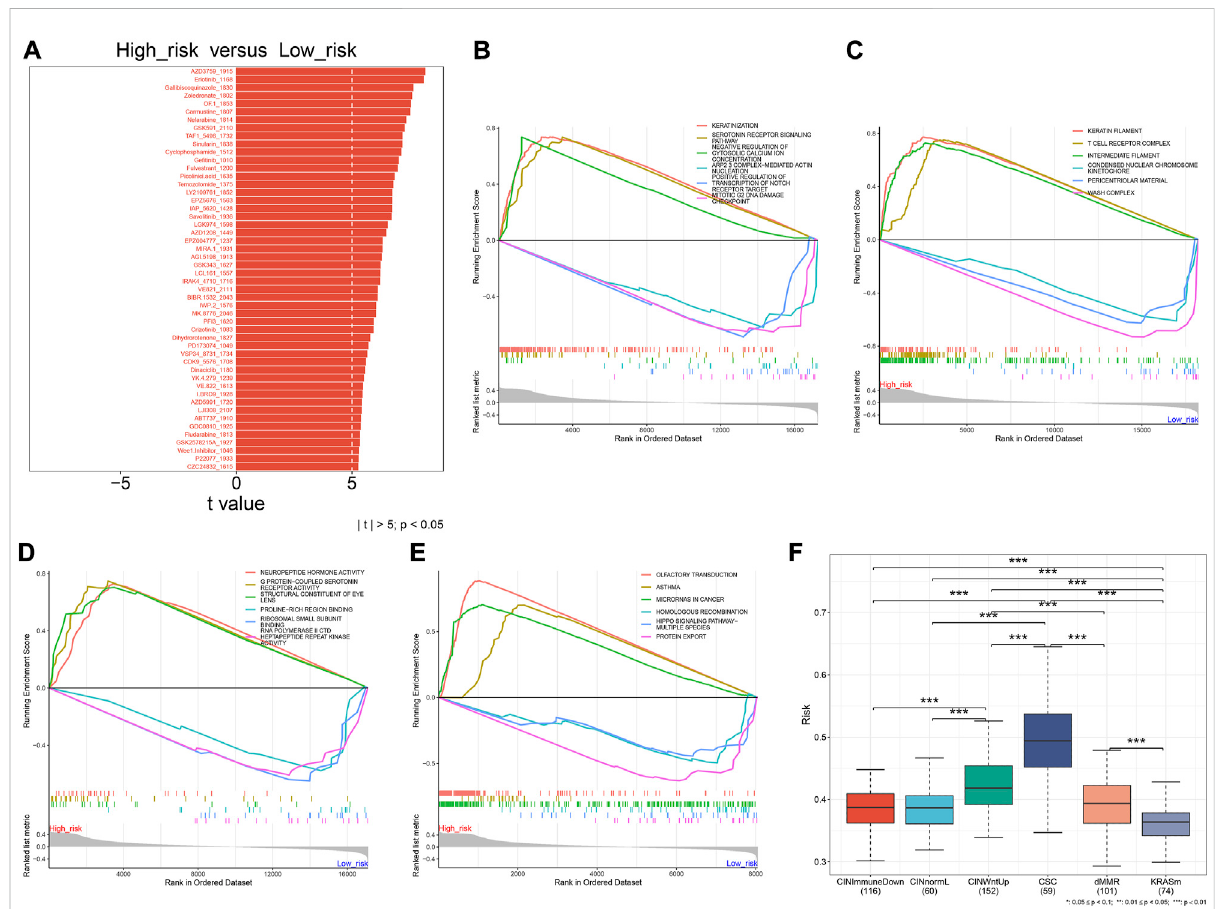
FIGURE 8 Oxidative stress-related gene signature is linked to drug sensitivity, signaling pathways, and molecular subtypes of CRC. (A) Difference in sensitivitytothetop50drugsbetweenhigh-andlow-risksubsets. (B – E) Differenceinbiologicalprocesses,cellularcomponent,molecularfunction, and KEGG pathways between subsets. (F) Difference in the risk score among molecular subtypes. *** p < 0.001. N =